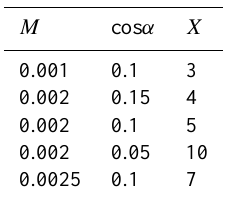
Fig. 8. A slab of infinitesimal width d x with constant plasma den- sity propagating into a radar beam height gate of diameter d , height h and width w perpendicular to the direction of